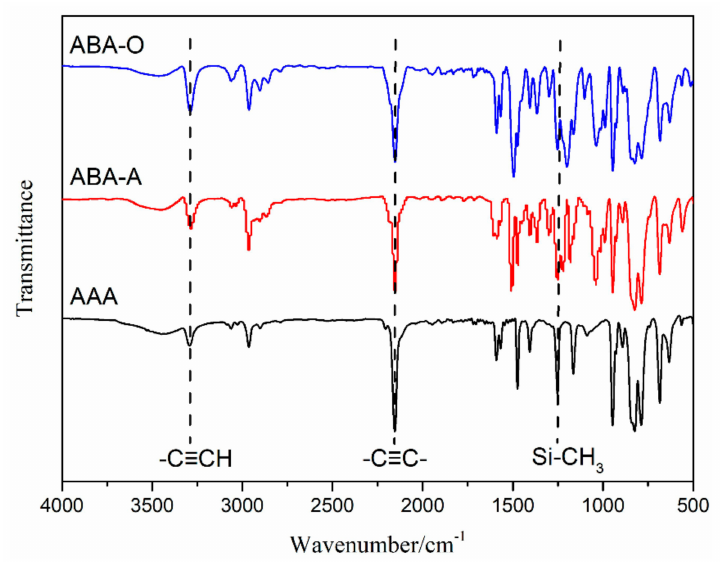
Figure 2. FT-IR spectra of three polymers.